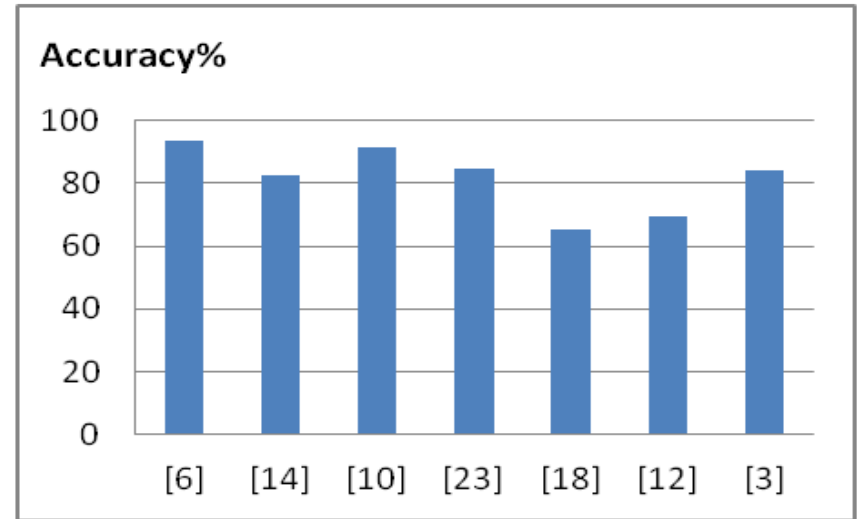
Figure 1 . Sentiment analysis for movie review